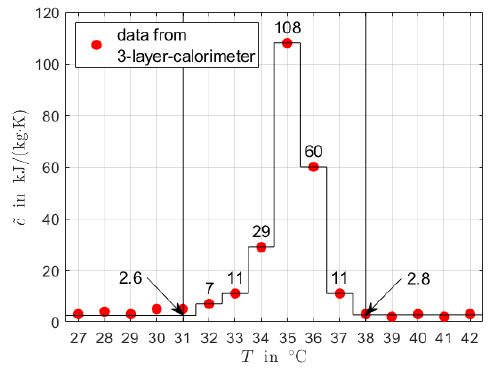
Figure 1. RT35HC heat capacity data for heating given as partial enthalpies. The original data are transformed to apparent specific heat capacities. Moreover, the start and end of the phase transition temperature range and constant solid and liquid properties c s p and c l p , respectively, are